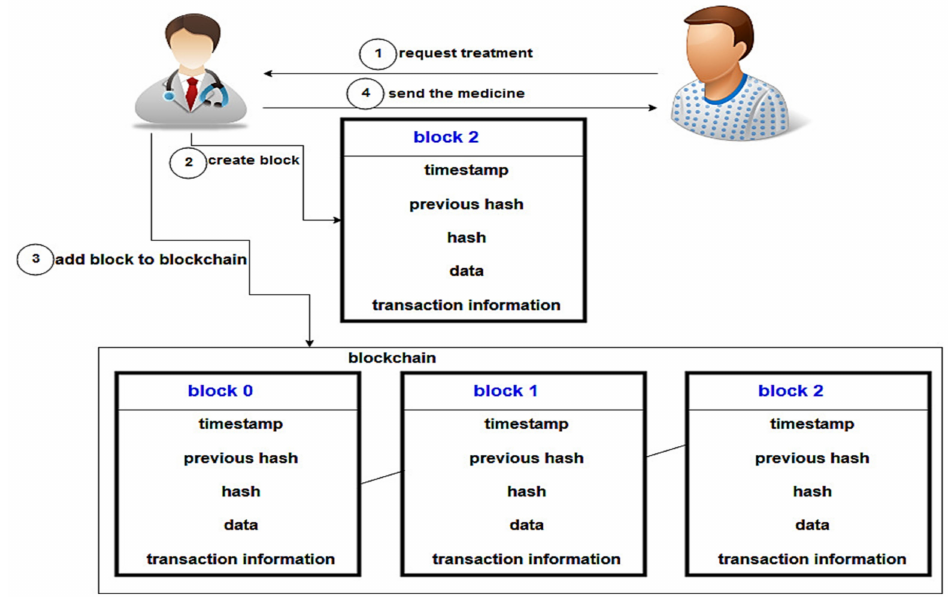
Figure 3. The blockchain-based medical record security